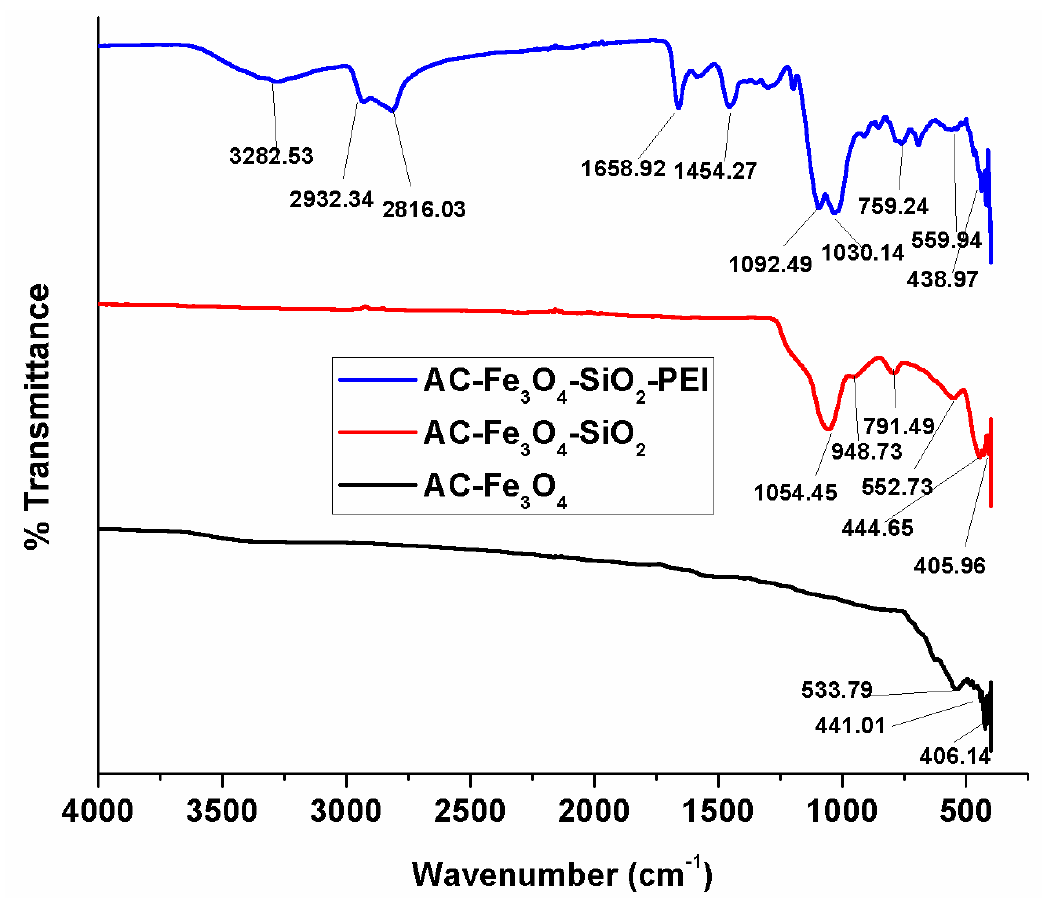
Figure 1. FTIR spectra of AC-Fe 3 O 4 , AC-Fe 3 O 4 -SiO 2, and AC-Fe 3 O 4 -SiO 2 -PEI.